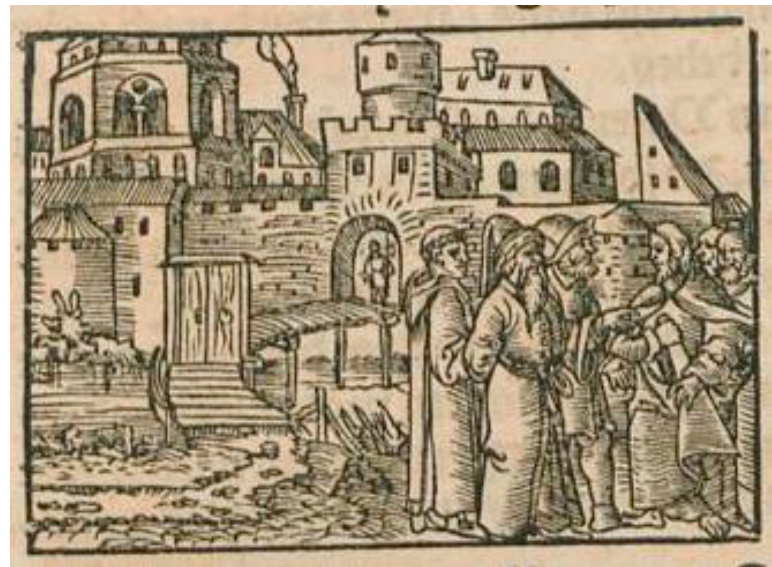
Figure 9. Woodcut recurring in books published by vom Berg and Neuber: Christ and the Pharisees [R 56], in (Luther 1545a, part 2, fol. CXXXIIIv) (Halle, Salle, Universitäts- und Landesbibliothek Sachsen-Anhalt, urn:nbn:de:gbv:3:1-102424).